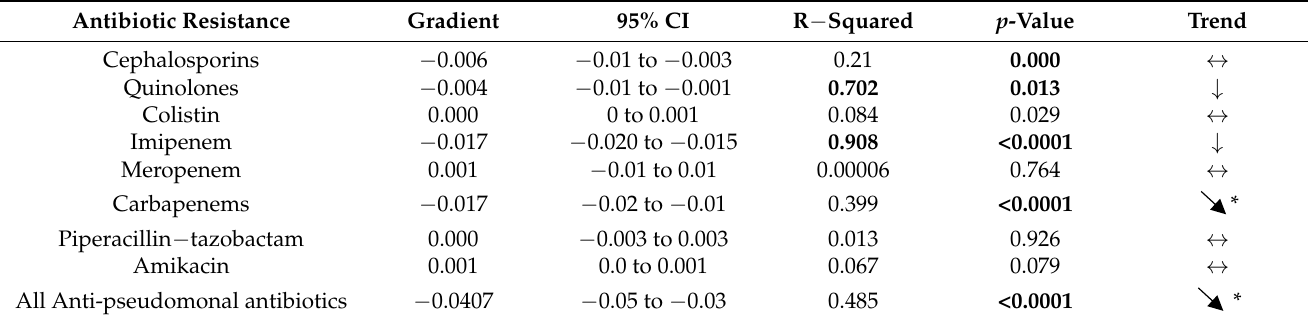
Values in bold are considered statistically significant (R-squared > 0.5 and p -value < 0.05). ↓ : down- ward trend; ↑ : upward trend; ↔ : no trend; * downward trend with only p -value < 0.05